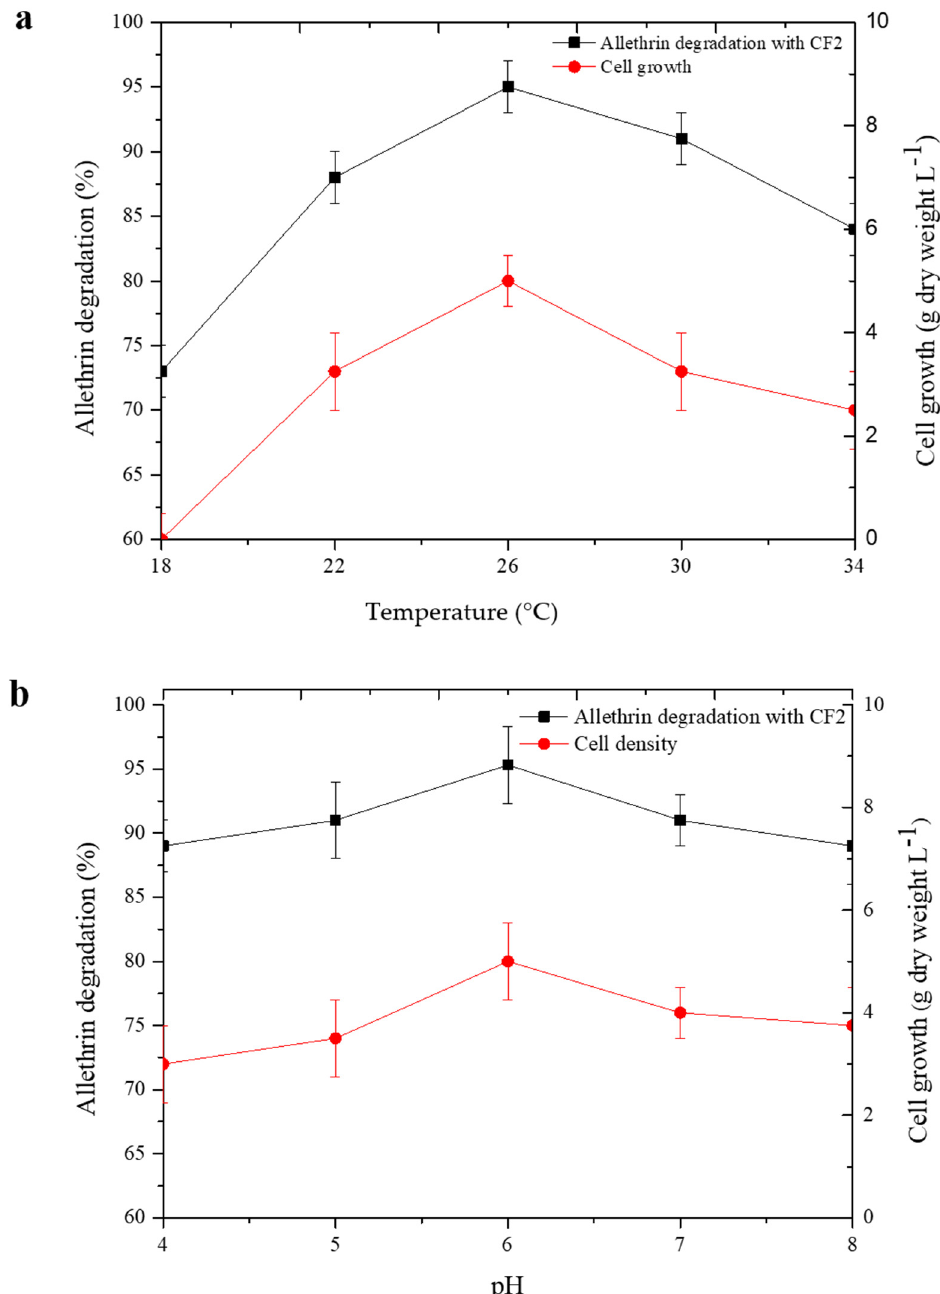
Figure 2. Effect of temperature ( a ) and pH ( b ) on the degradation of allethrin by strain CF2. The data presented are mean ± standard errors of three independent experiments.